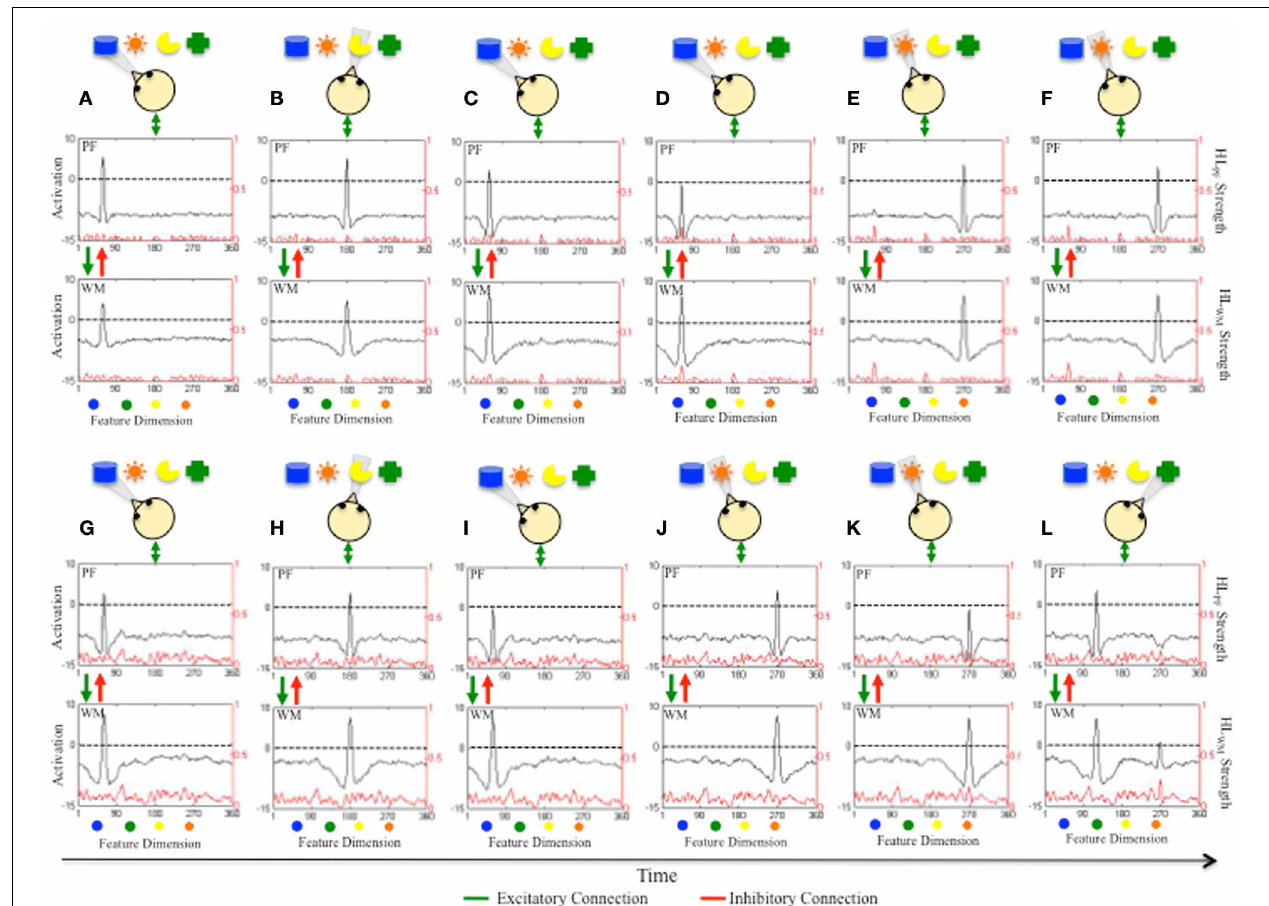
FIGURE 2 | Illustrates how the accumulation of experience in HL PF and HL WM over a continuous dimension influences real-time exploration of items distributed along that dimension. Shown at the top of each panel are 5 objects distributed along the color dimension that the model is exploring over time. The cartoon infant shows the direction of gaze. Panels (A–F) show how the model explores items after little experience has accumulated in HL PF and HL WM (see red line, right y-axis). Initially, the model is fixating, encoding, and forming a working memory for the blue item (see black line in A ). The model spontaneously switches gaze and begins to encode and form a working memory for the yellow item (B) . The model then looks back to the blue item (C) . Dwelling on the blue item leads WM activity to grow in strength and suppress activity in PF (D) . This frees the model to